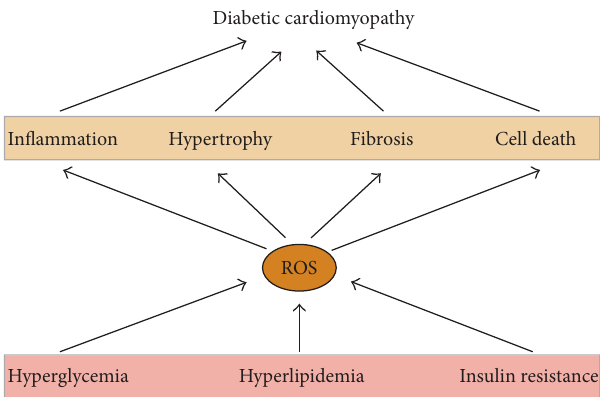
Figure 3: Pathological responses mediated by ROS in the diabetic heart. ROS are involved in the proinflammatory, -hypertrophic, and -fibrotic as well as cell-death processes developed in the diabetic